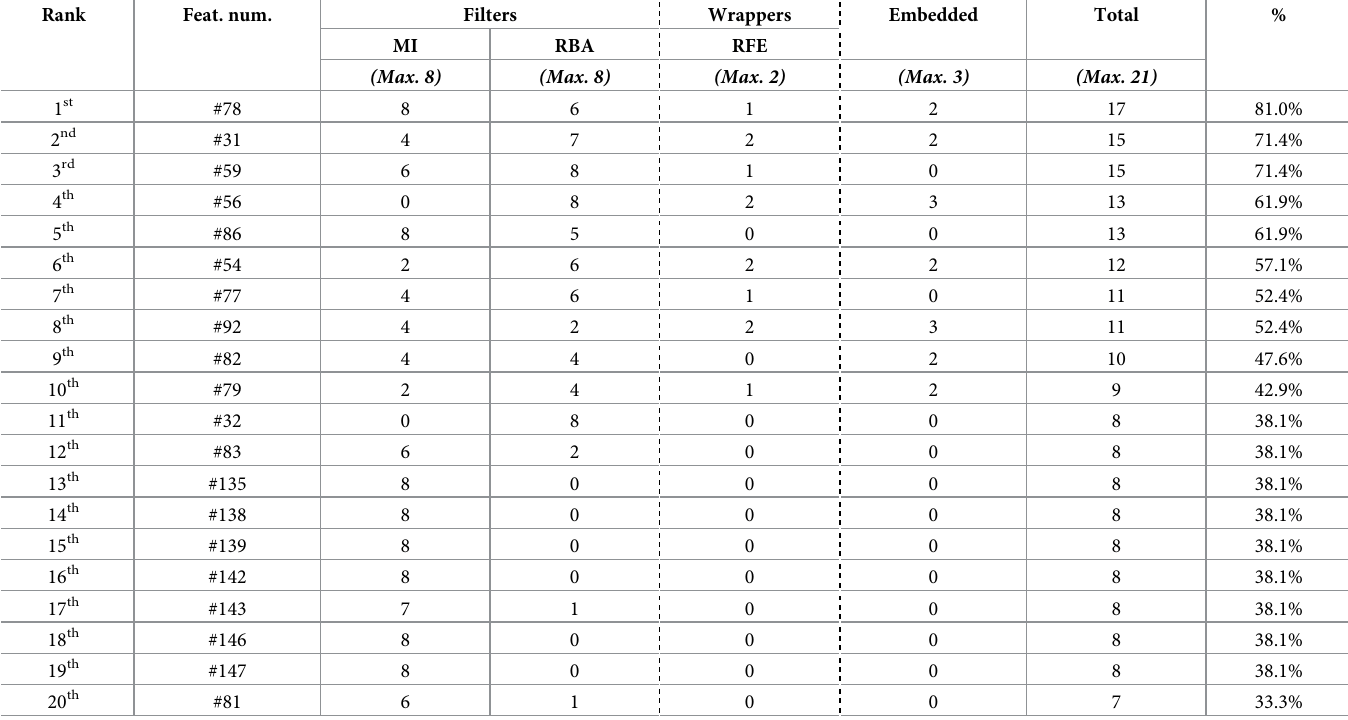
Table 6. Top-20 selected features. Out of the 21 stable FS configurations, how many of them selected a certain feature for ⩾ 80% of the M = 100 bootstrap iterations. Rank Feat.